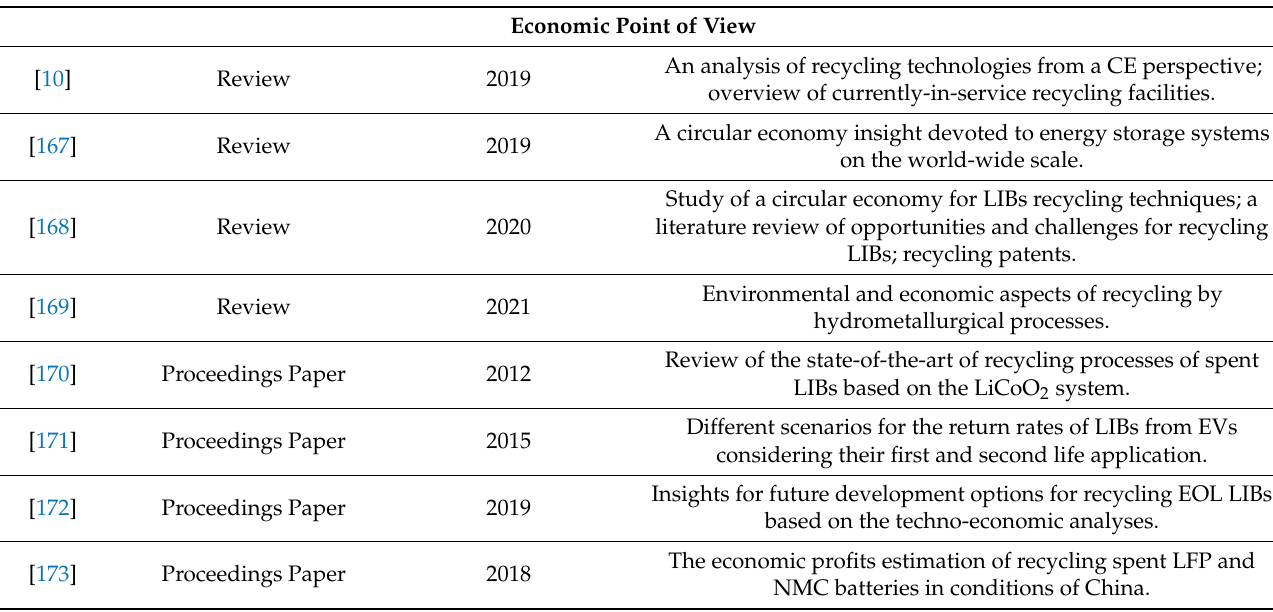
Table A6. Assessed literature in review for “Economical Evaluation”